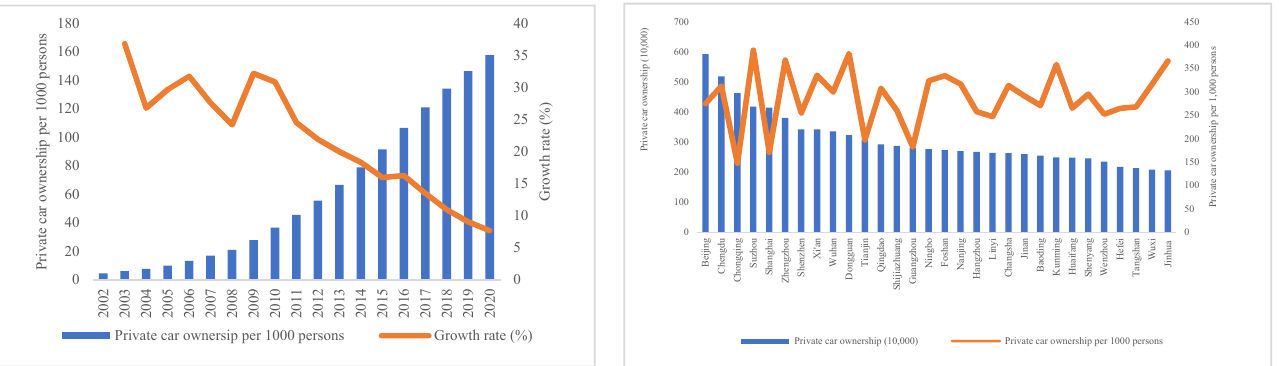
Figure 1. Private car ownership per 1000 persons and growth rate (%) in China from 2002 to 2020 ( left ) cities with more than 2 million cars owned in 2019 ( right ) Source: data compiled from National Bureau of Statistics, 2021 [9].